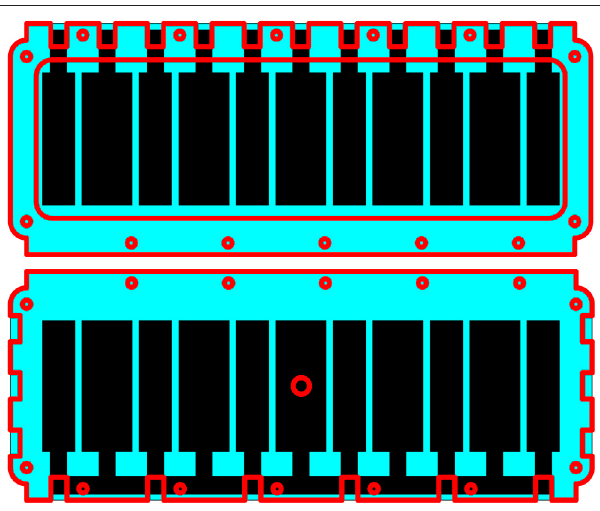
FIGURE 7 | Structure of the PILA test setup, red lines indicate the position of the edges of acrylic support frames. Top: Top view. Bottom: Bottom view. Small holes show bolt placement, large central hole shows air tube